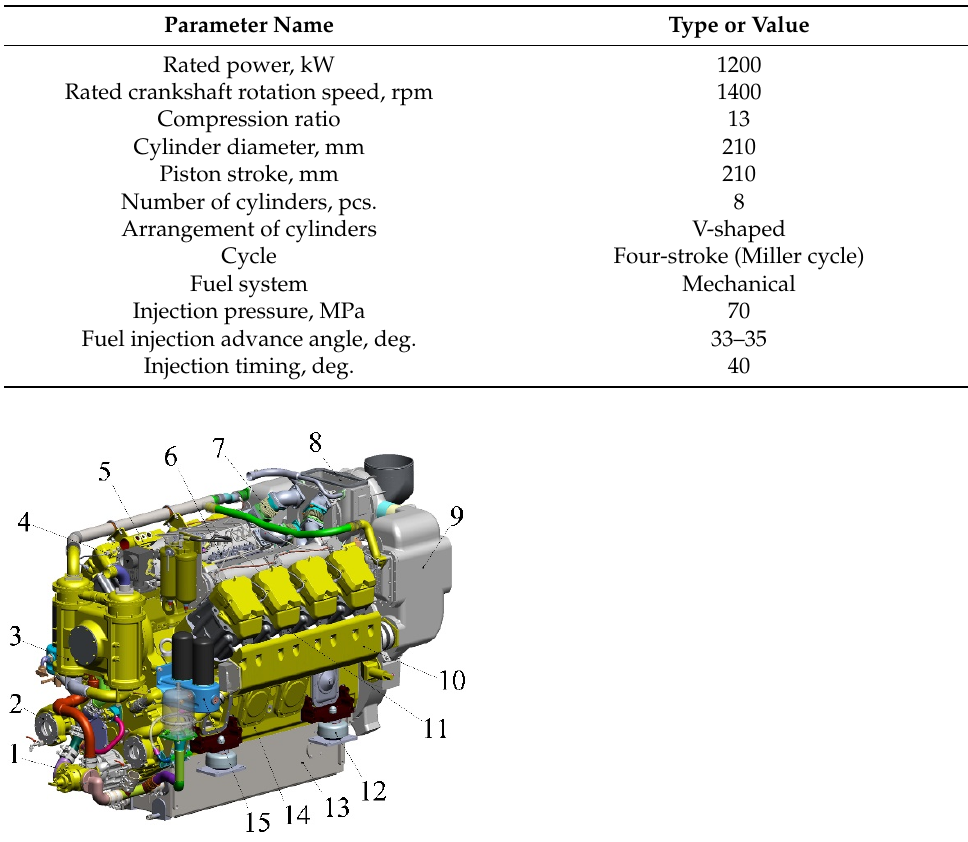
Table 1. Basic technical parameters of the basic diesel engine.